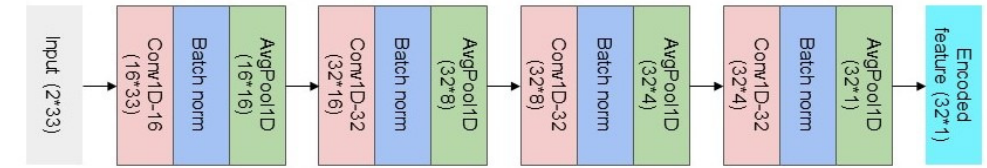
Figure 3. The detailed network architecture of the pose feature encoder that is used in the proposed